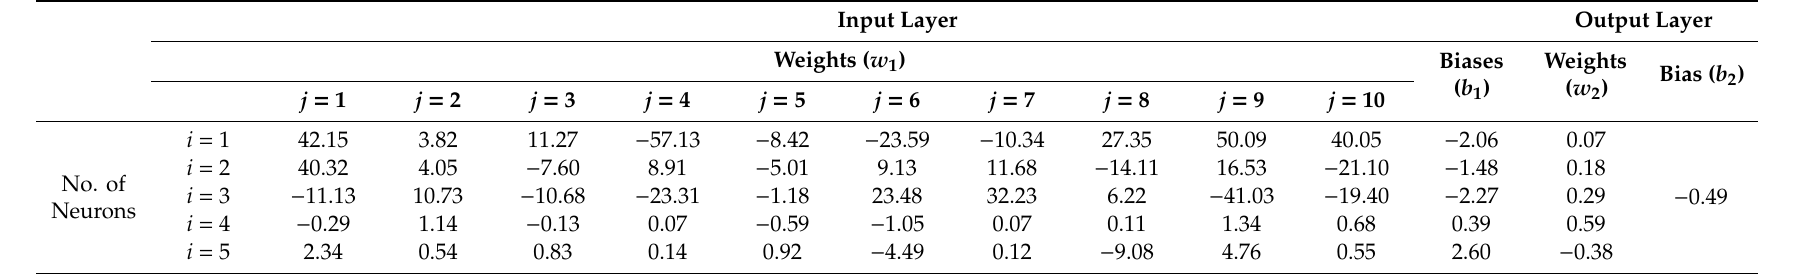
Table 3. The proposed ANN-based weights and biases for RF calculations with Equation